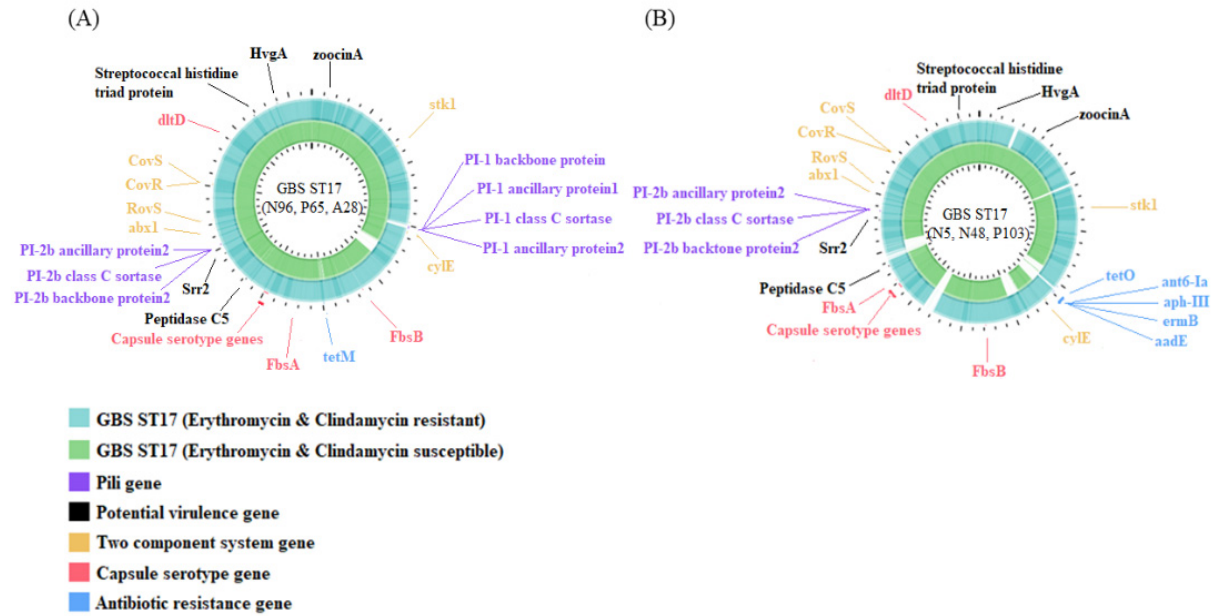
Figure 2. Whole-genome analysis of antibiotic susceptible (N5, N48, P103) and resistant (N96, P65, A28) serotype III/ST17 GBS strains. Genome scale in mega base pairs of these two reference strains are given in the innermost circle, respectively. TBLASTN comparisons of the reference NGBS128 (CP012480) genome ( A ) and B105 (CP021773.1) genome ( B ) to the complete genomes of antibiotic resistant and susceptible III/ST-17 GBS strains are shown in different colors. The genomes of two component systems CovS/R and genes related to capsular serotypes, pili, virulence and antibiotic resistance are presented in different colors.